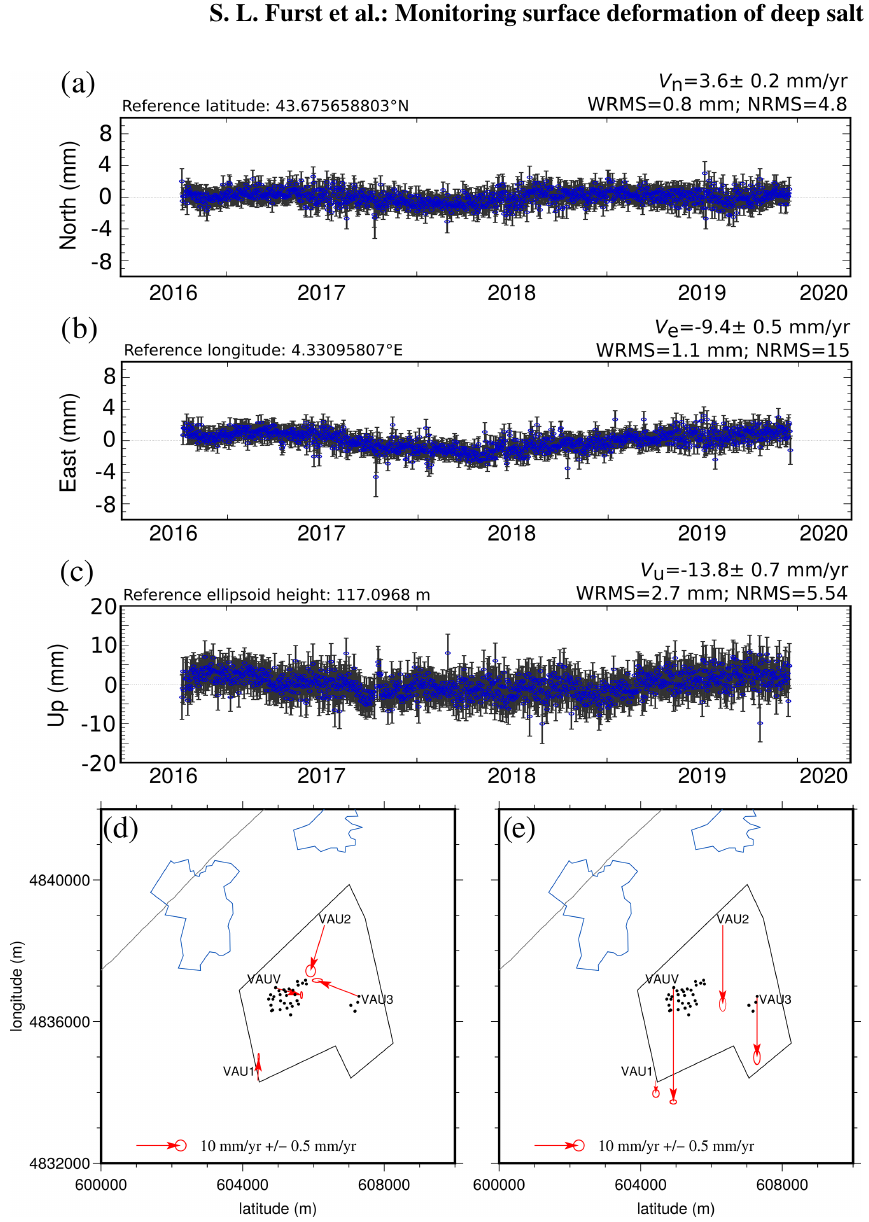
Figure 5. Time series of the three components (a) north, (b) east, and (c) vertical, measured at station VAU3 from 2016 to the end of 2019. (d) Map of horizontal velocities and well locations. (e) Vertical velocities, downward being subsidence. The polygons represent the extent of Vauvert and Beauvoisin cities (blue) and the KemOne company area (black; see Fig.